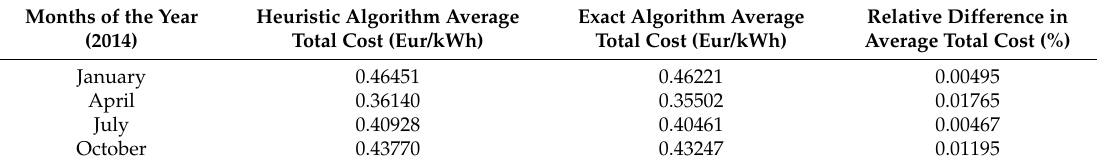
Table 2. Simulation Result of 2TP/RTP Model across representative seasons of the year.